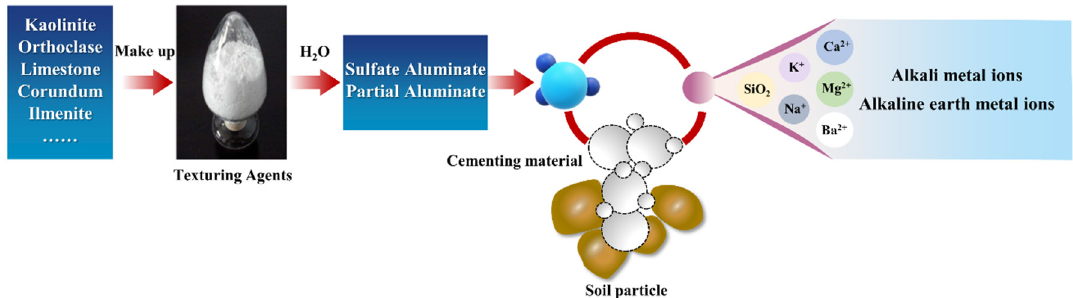
Figure 1. Reaction principle of new, high-strength, fast anchor. The active SiO 2 content in the new, high-strength, fast anchorage agent was